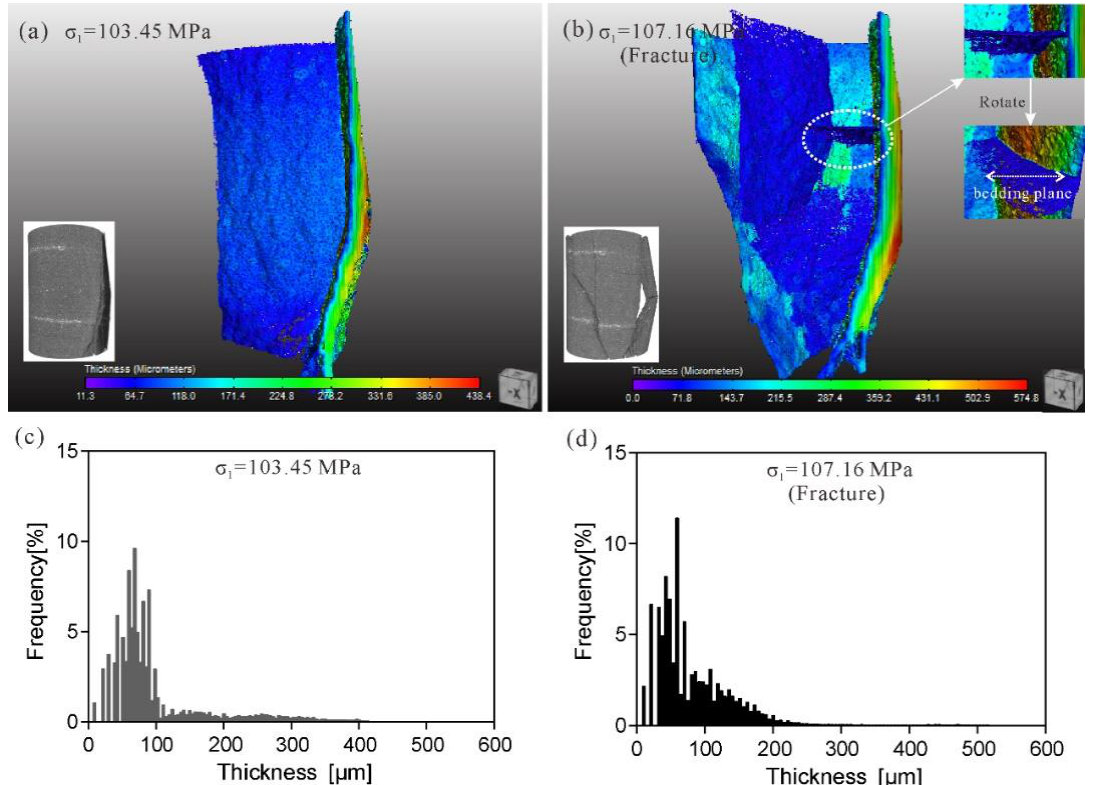
Figure 10. Crack propagation patterns of different load stages in SZB3. ( a ) Crack at σ 1 = 103.45 MPa; ( b ) Crack of the fractured specimen (after σ 1 = 107.16 MPa); ( c ) crack thickness at σ 1 = 103.45 MPa; ( d ) crack thickness (after σ 1 = 107.16 MPa). Rainbow colors represent the thickness value ranges from low to high, and red means highest. The cross-sectional views show the center slice of the specimen.